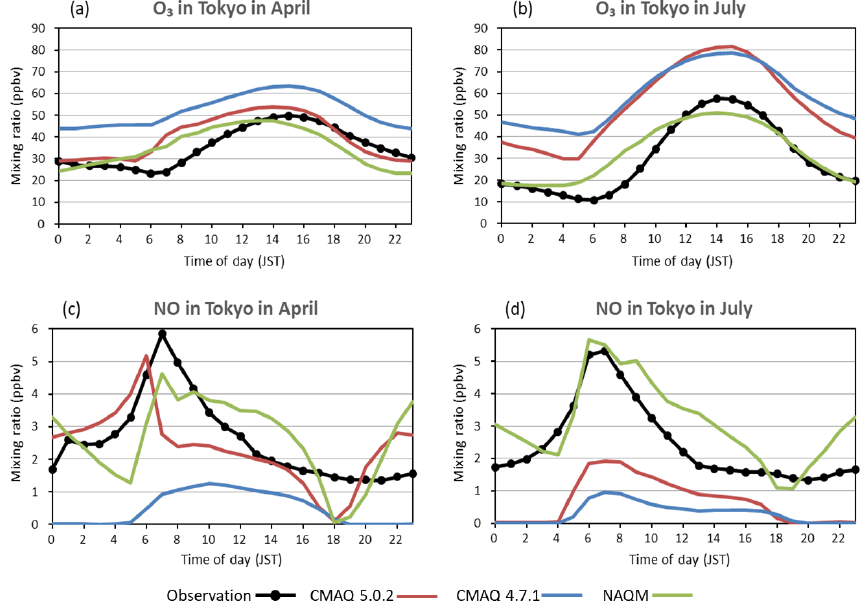
Figure 3. Monthly averaged diurnal variation in Tokyo, (a) O 3 in April, (b) O 3 in July, (c) NO in April, and (d) NO in